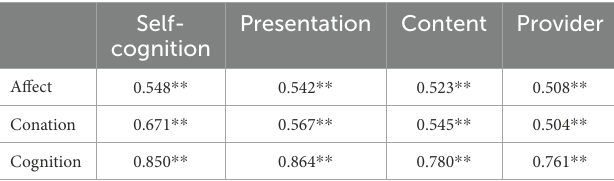
TABLE 4 Pearson’s correlation coefficient table for the predictive variables and the latent variables.